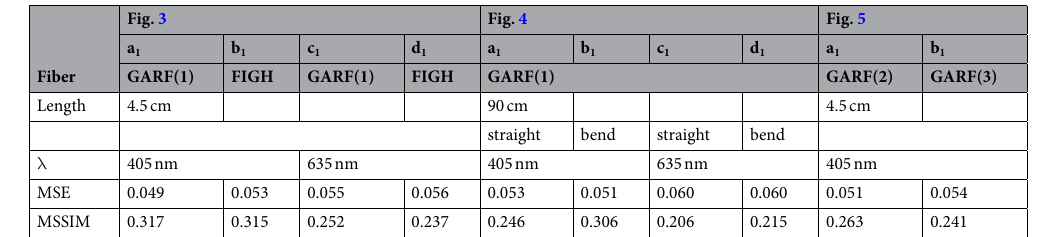
Table 1. MSE and MSSIM values of transported images. Note that a smaller MSE value and a greater MSSIM value indicate higher fidelity to the original image. FIGH is the Fujikura FIGH-10-500N multicore imaging